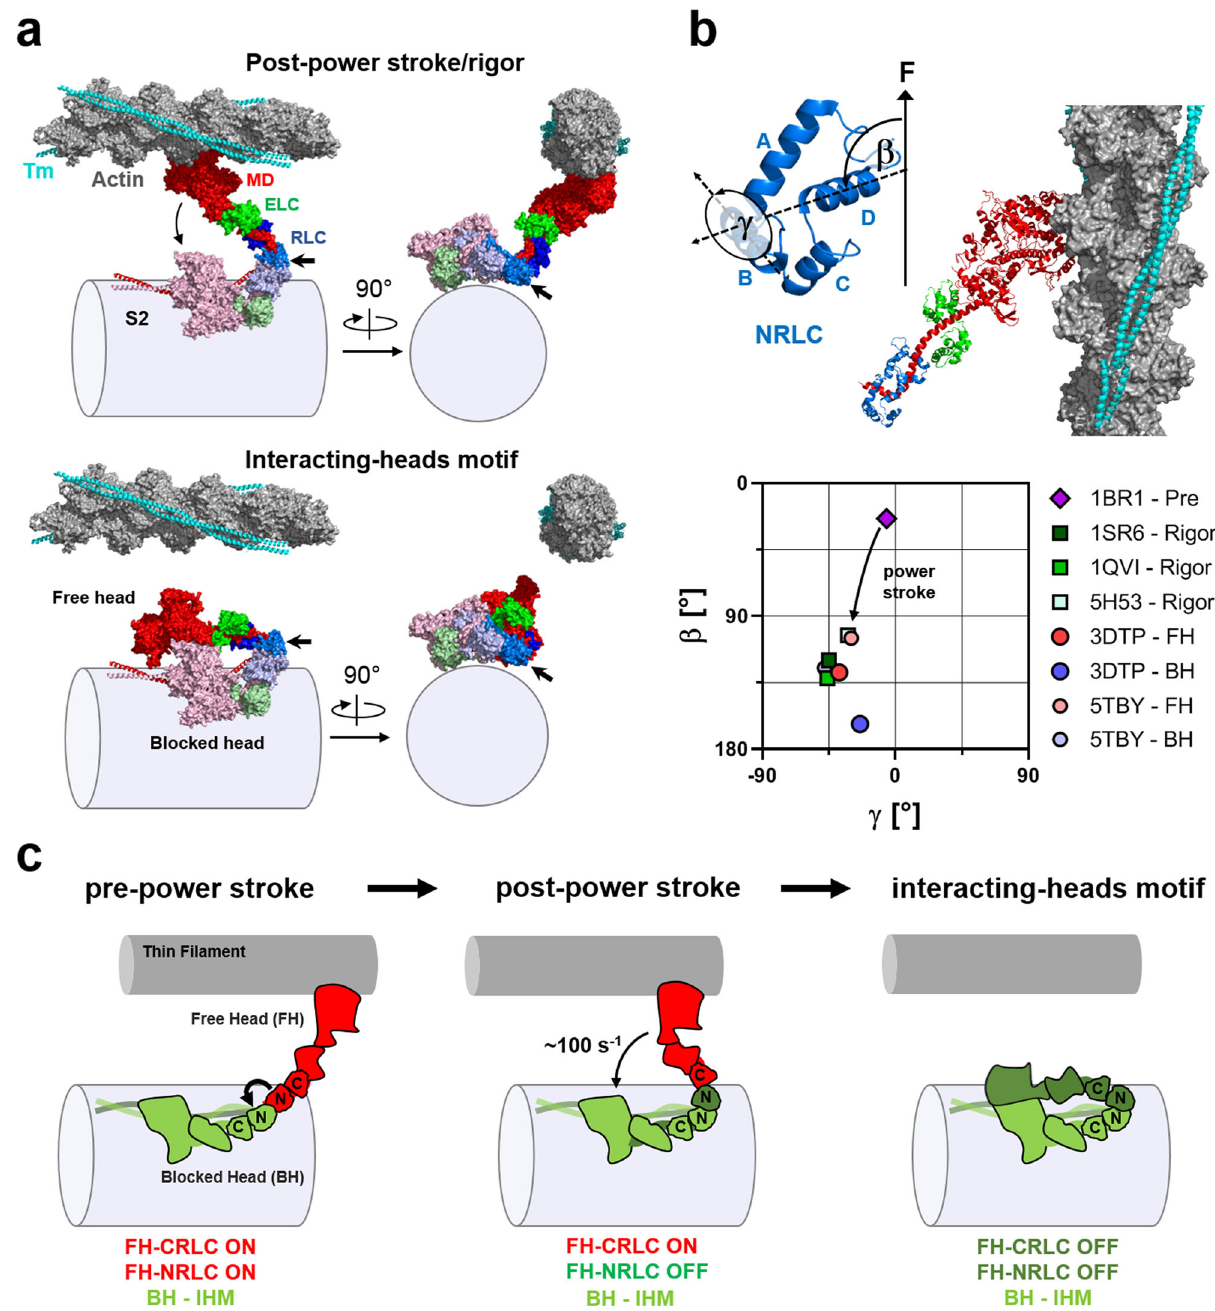
Fig. 5 Sequential folding of cardiac myosin heads into the OFF state during active shortening. a Top: surface representation of the free myosin head attached to actin in the rigor state and the blocked head in the IHM OFF state. Bottom: Surface representation of myosin heads folded into the interacting- heads motif (IHM). Please note that the free head can transition from the actin attached rigor state to the IHM without re-orientation of its RLC N-lobe (light blue, indicated by arrows). b Top: molecular reference axes used to describe the RLC N-lobe orientation. β describes the angle between the D-helix and the fi lament axis, and γ describes the rotation of the RLC N-lobe around the D-helix. Bottom: The ( β , γ ) orientation of the chicken smooth muscle myosin S1 in the pre-power stroke state (PDB 1BR1) docked onto F-actin is shown as a purple diamond. The orientation of the RLC N-lobe in different rigor myosin S1 structures (PDBs 1SR6, 1QVI, 5H53) docked onto F-actin is shown in squares. Orientations of the blocked head and free head NRLC in the IHM from tarantula skeletal (PDB 3DTP) and human cardiac muscle (PDB 5TBY) are indicated by circles. c Model for the sequential folding of myosin heads into the IHM OFF state during cardiac muscle active shortening. See main text for